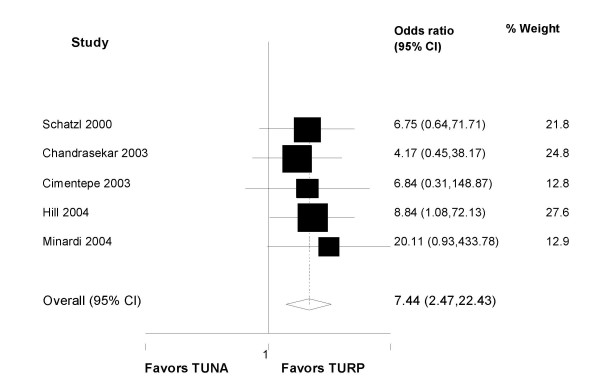
TUNA vs. TURP. Need for new therapeutic interventions. Random effects model.  CI denotes confidence interval Chi-squared heterogeneity = 0.70 (d.f. = 4), P = .951. Overall effect P value = .000.